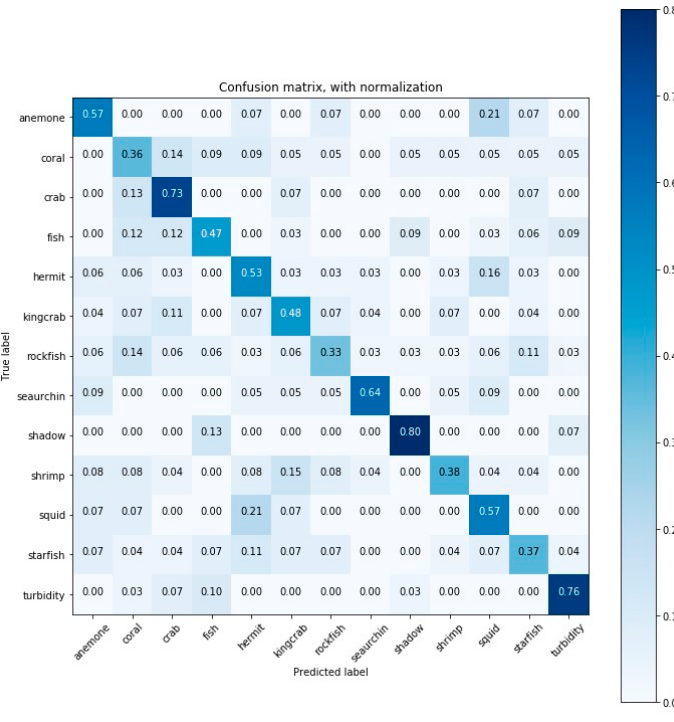
Figure A5. Confusion matrix for the classification results (accuracy) obtained by decision tree (DT) DT-1.